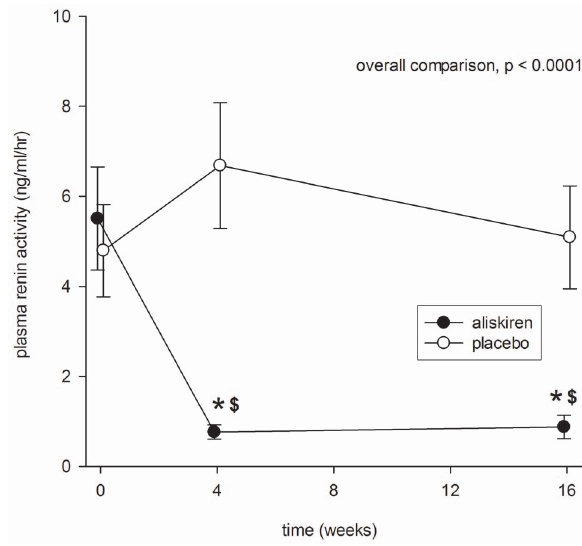
Figure 5. Serial change in plasma renin activity during the periods of aliskiren (closed circles) and placebo (open circles) treatment. Error bars denote standard error of mean. Post-hoc comparisons were performed by paired Student’s t test: *p , 0.0001 as compared to baseline level; $ p , 0.0001 as compared to the period of placebo treatment. All P values were computed with Bonferroni adjustment for multiple comparisons.